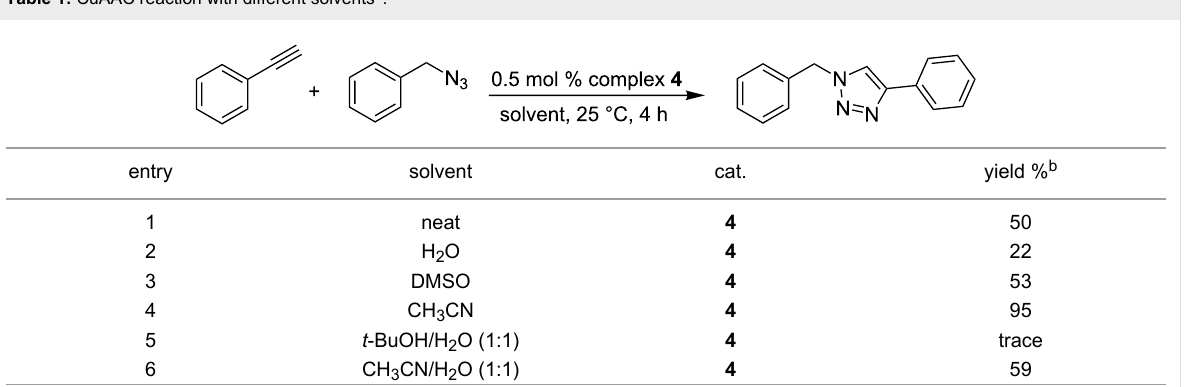
Table 1: CuAAC reaction with different solvents a